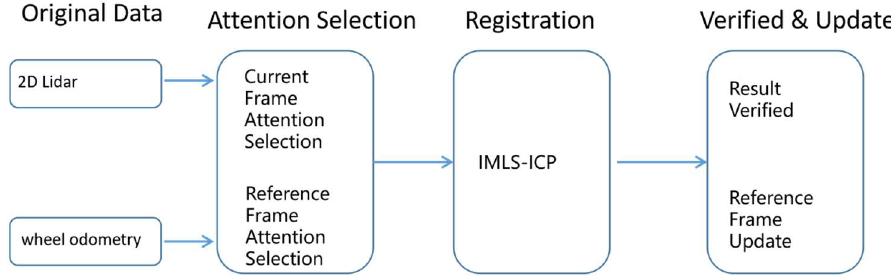
Figure 1. System overview.